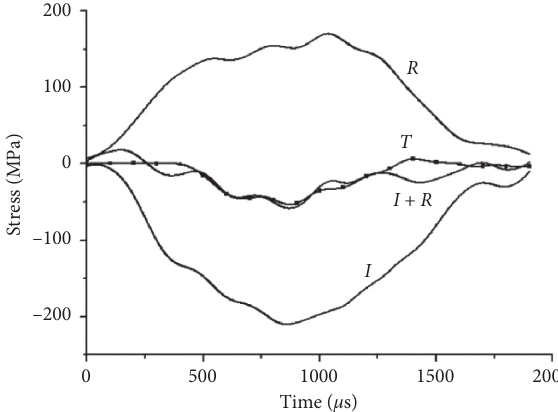
Figure 2: Dynamic stress equilibrium